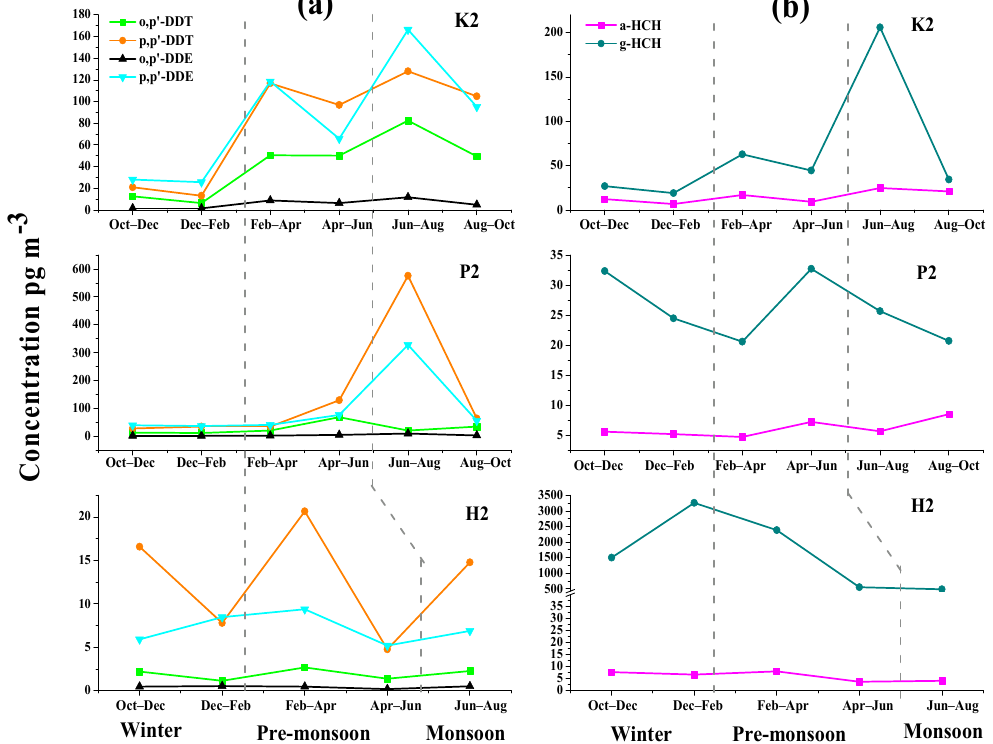
Figure 4. Seasonal variation of (a) DDTs and (b) HCHs in vegetable market or production area (K2, P2, and H2).